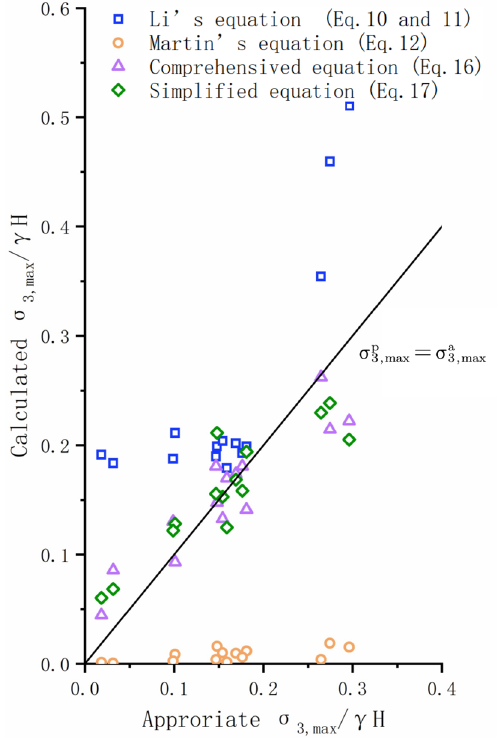
σ ′ 3,max γ H values and predicted values from different equations (